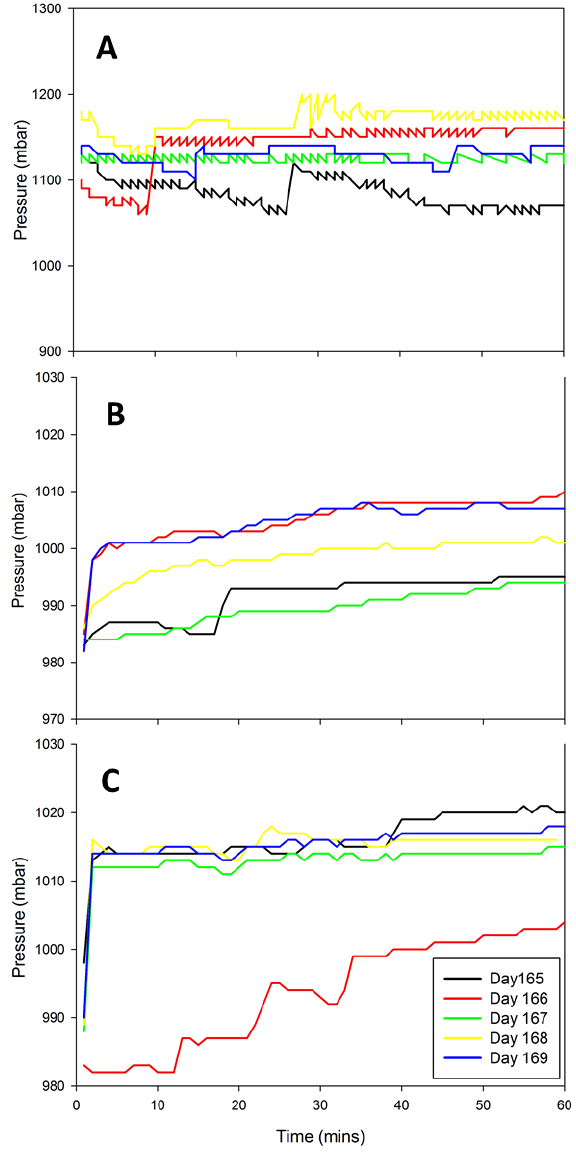
Figure 4. Pressure reading on different days, black — day 165, red — day 166, green — day 167, yellow — day 168, blue — day 169. ( a ) Measurements taken at the top of baffled side — compartment A of the optimised digester; (b) measurement taken at the top of the unbaffled side — compartment B of the optimised digester; (c) measurement taken at the top of the blank digester. The blank digester has only one compartment.